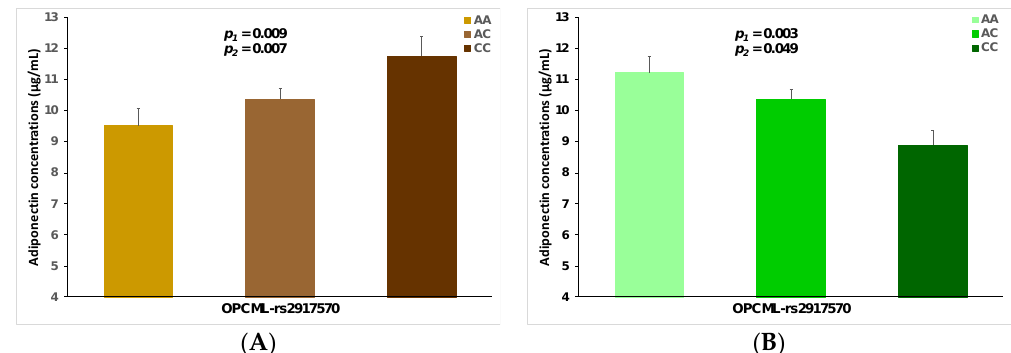
Figure 6. Gene–diet interaction effect between the SNP rs2917570, located in the opioid-binding protein/cell adhesion molecule ( OPCML ), chromosome 11, and adherence to the Mediterranean diet: low adherence (panel ( A )) and high adherence (panel ( B )) on plasma adiponectin concentrations (ln-transformed) in the whole population. p -values were obtained in the general linear regression models: unadjusted (1) and adjusted for sex, age, diabetes, BMI, smoking and physical activity (2). Error bars: (SE) of means. Genotype prevalence: AA (25%), AC (54%) and CC (21%).